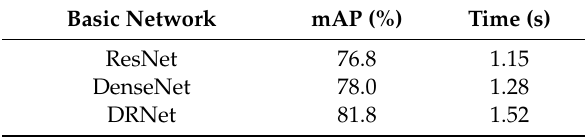
Table 2. Experiment results depend on di ff erent basic